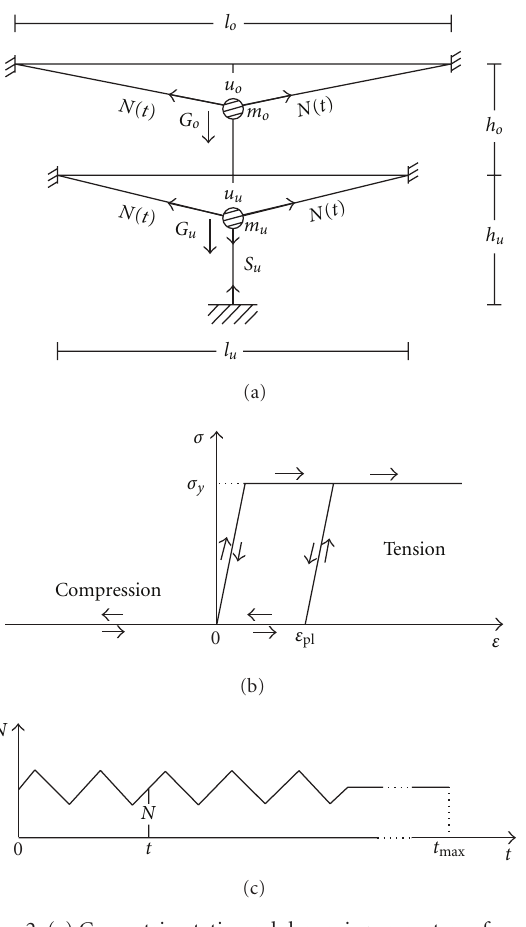
Figure 2: (a) Geometric, static, and dynamic parameters of a cable structure. (b) Primary σ - ε diagram describing the nonlinear axial stress-strain law of a cross-tie. (c) Given time-history of axial forces of